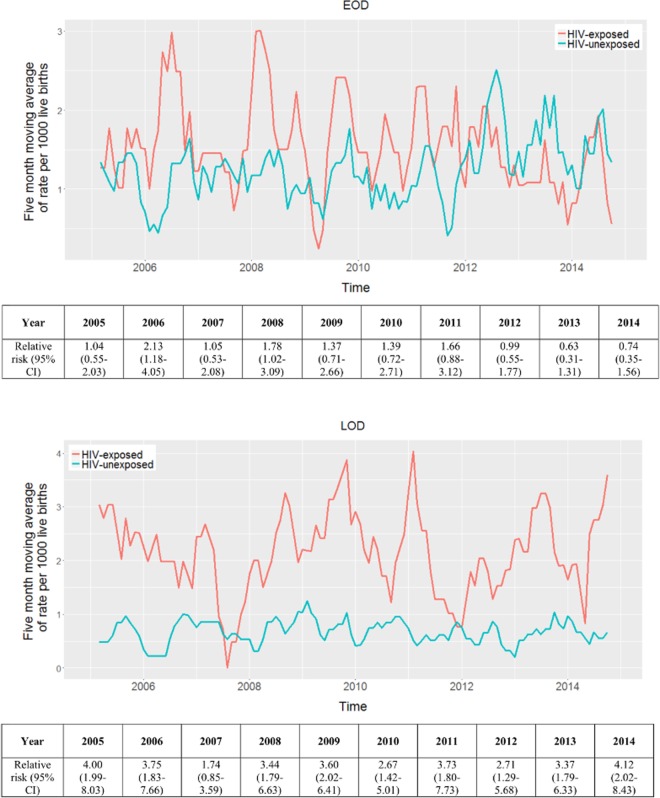
Five-term moving average of early-onset disease (A) and late-onset disease (B) stratified by HIV-exposure status. Footnote: Relative risk comparing HIV-exposed and unexposed infants per year.